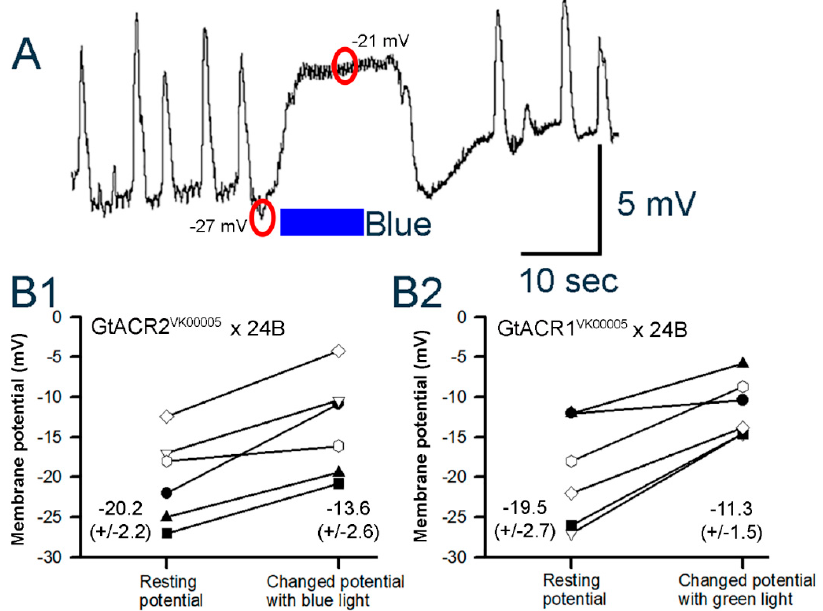
Figure 8. Membrane potential changes in heart muscle 3 rd instar larva for GtACR2 VK00005 × 24B and GtACR1 VK00005 × 24B lines. ( A ) The heart is rhythmically beating while recording with an intracellular electrode in a GtACR2 VK00005 -expressing larva. Upon the blue light pulse the membrane depolarizes and the beating ceases. Note the small fluctuation in the membrane potential during the light pulse and for a short while after the light is off. The change in membrane potentials of the heart from resting condition to peak response during the 10 s light pulse for GtACR2 VK00005 ( B1 ) and GtACR1 VK00005 ( B2 ) lines is shown for each preparation. The circles overlaying on the trace indicate where the membrane potential is measured. Mean (± SEM) values are presented next to each distribution.